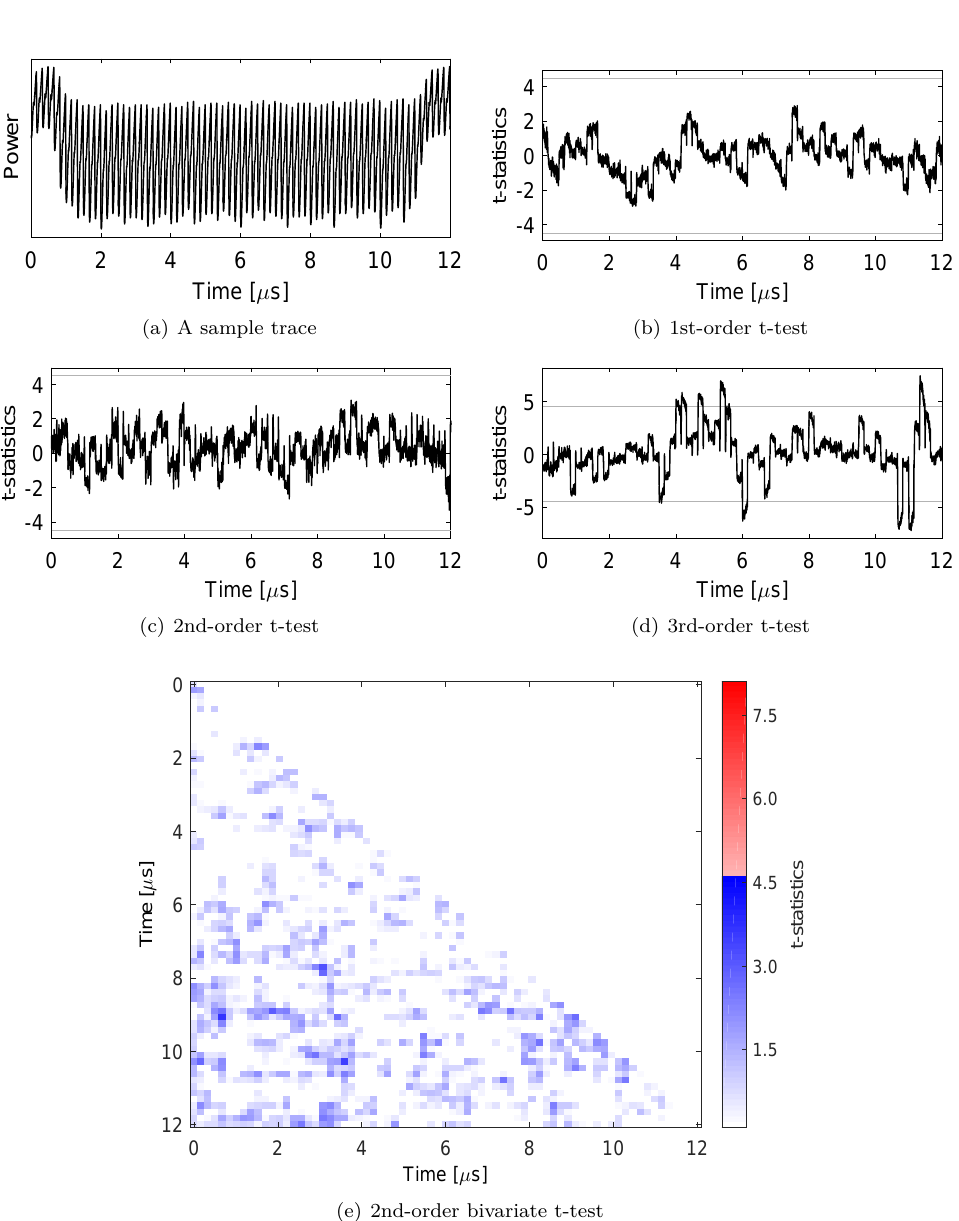
Figure 9: Experimental analysis of our second-order secure round-based Midori-64 encryp- tion design, 100 million